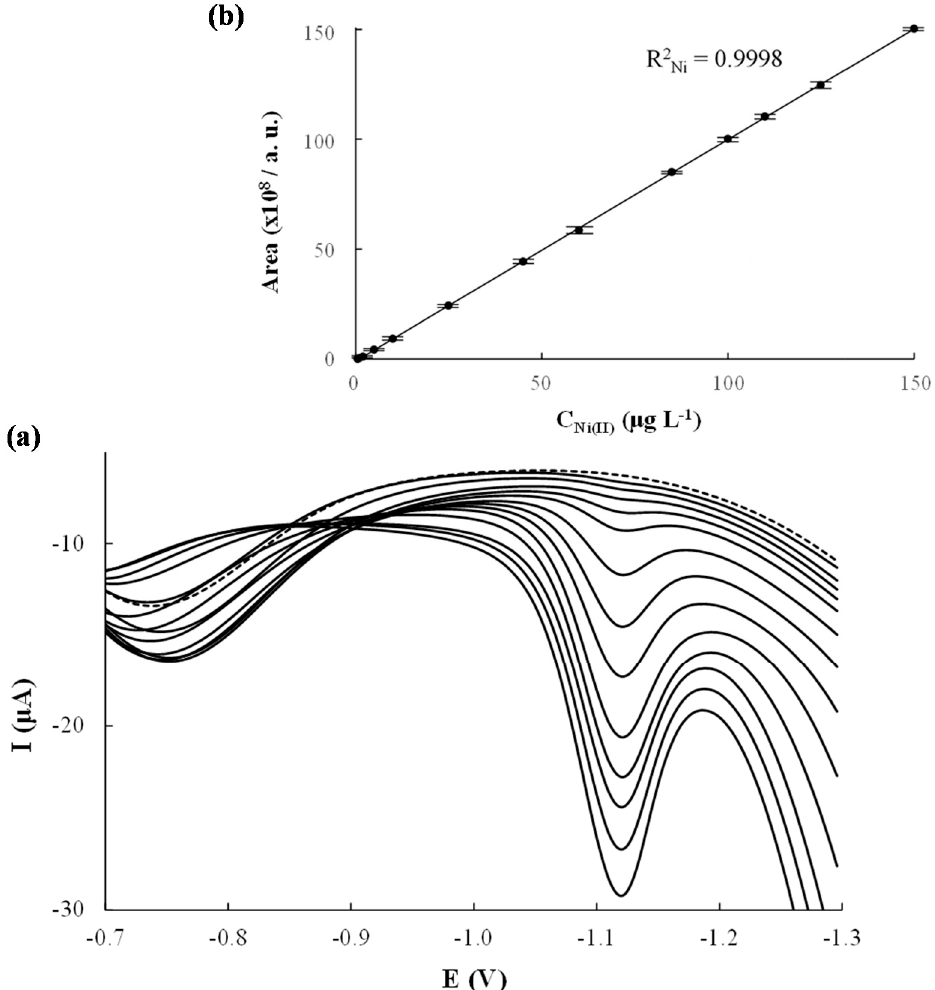
Figure 2. ( a ) Adsorptive voltammograms and ( b ) calibration plots of Ni(II) using a SPCE in 0.1 mol L − 1 ammonia/ammonium buffer solution (pH 9.2) and 5 × 10 − 5 mol L − 1 dimethylglyoxime (DMG) applying a E d of − 0.7 V and a t d of 120 s. Blank signal in dashed line. In ( b ) error bars of the peak areas are shown.